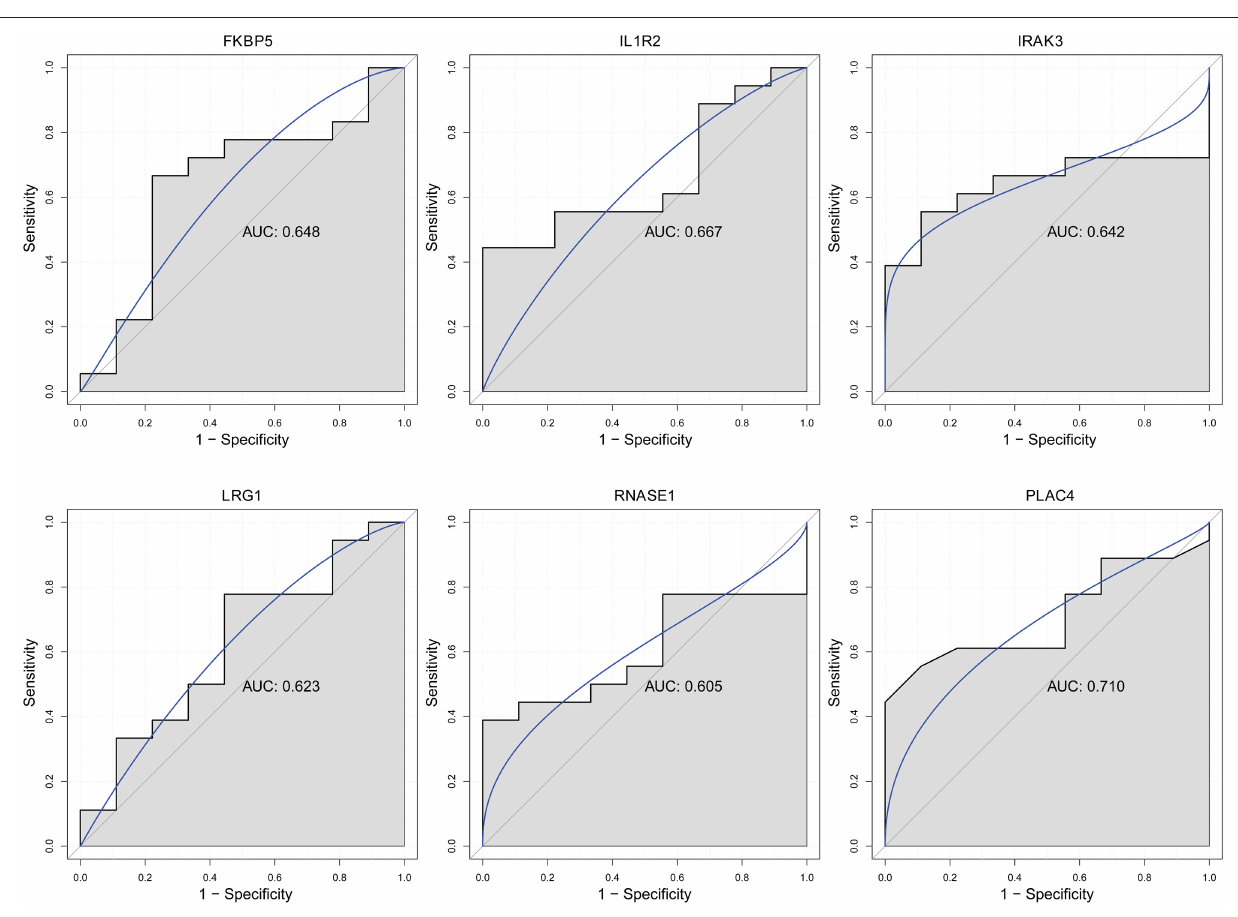
FIGURE 7 | The ROC curves of FKBP5, IL1R2, IRAK3, LRG1, RNASE1, and PLAC4 in HF. The ROC curves were used to show the diagnostic ability with 1 – specificity and